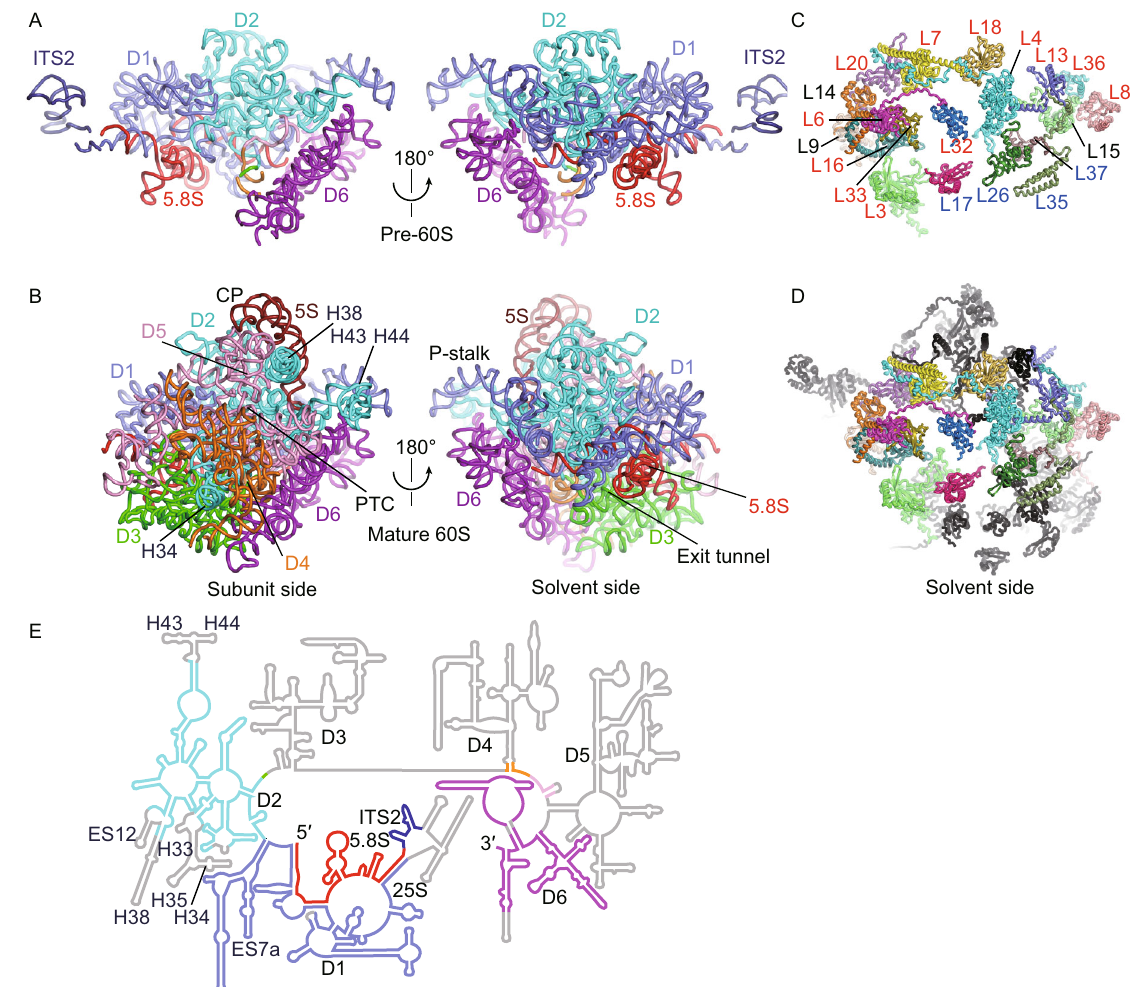
Figure 2. Structure of rRNAs and RPLs in Rpf1-TAP pre-60S and mature 60S subunit. (A and B) Structure of rRNAs in Rpf1-TAP pre-60S (A) and mature 60S (B). The subunit and solvent side views are shown. Domains I – VI of 25S are colored slate, cyan, green, orange, pink and purple, respectively. ITS2, 5.8S and 5S are colored dark blue, red and brown, respectively. Central protuberance (CP), peptidyl transferase center (PTC), polypeptide exit tunnel and P-stalk are labeled. (C and D) RPLs in Rpf1-TAP pre-60S (C) and mature 60S (D). The solvent side view is shown. RPLs present in pre-60S are color coded and those missing in pre-60S are shown in black in (D). The early, middle and unclassi fi ed RPLs are labelled in red, blue and black, respectively. (E) Secondary structure model of 5.8S, ITS2 and 25S RNA. The modeled regions are colored as in (A) and (B) and the unmodeled regions are colored